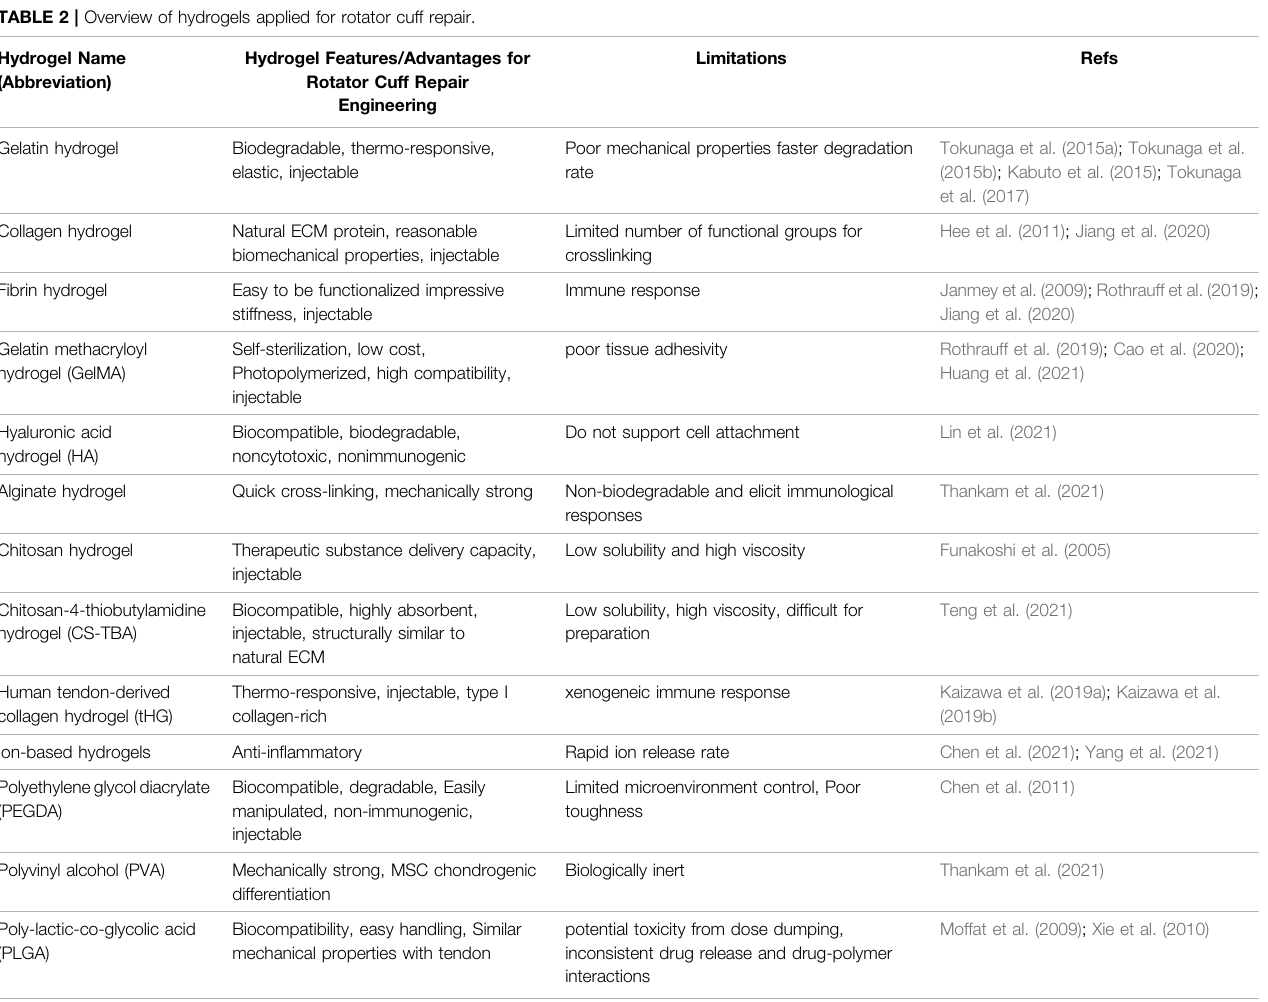
TABLE 2 | Overview of hydrogels applied for rotator cuff